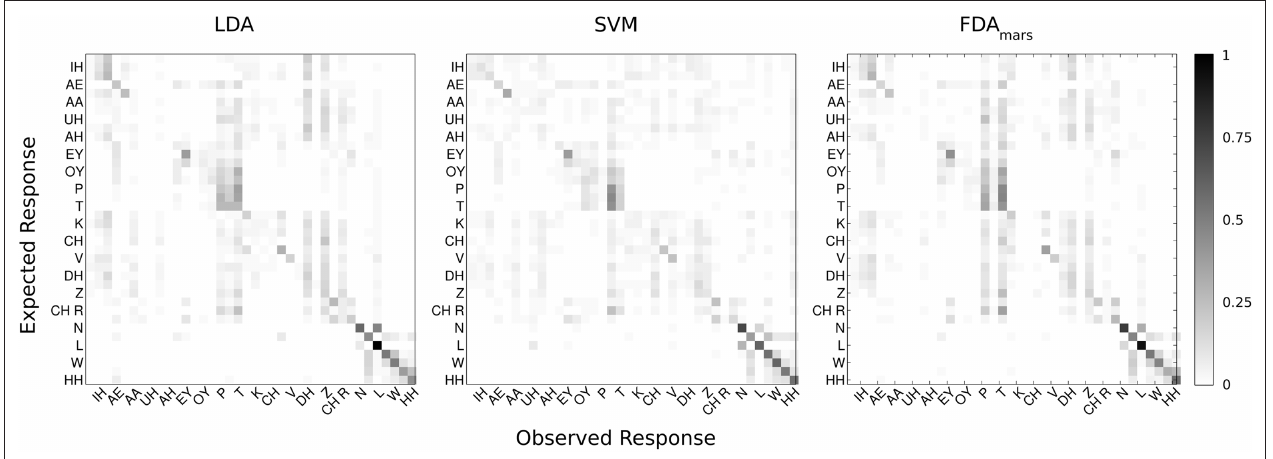
Figure 5 | Confusion matrices (expected Phoneme on y -axis, Classified Phoneme on x -axis) are displayed summarizing the cross-validated performance of each classification technique for all phonemes ( N = 38). Each matrix represents one of the classification methods: LDA, SVM, and FDA. Every other phoneme is labeled for readability. The confusion matrix color scale is normalized across methods and increases from white to black as a function of increasing classification rate.